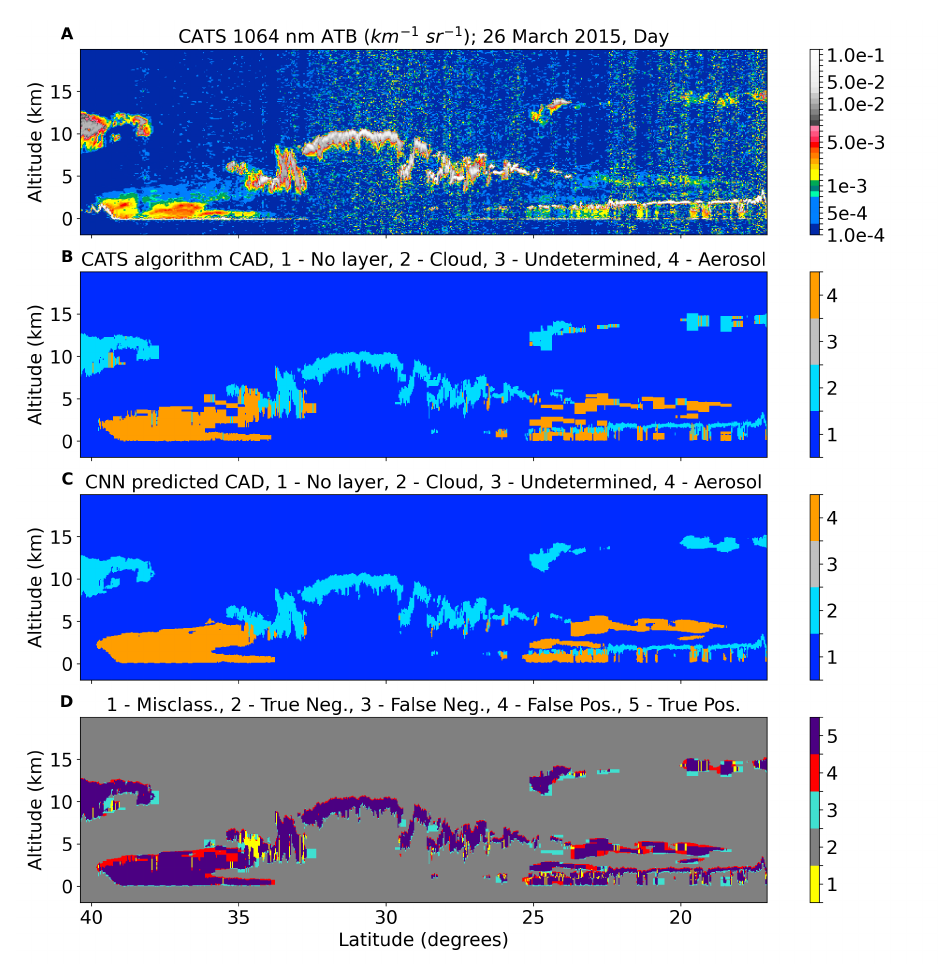
Figure 8D. Furthermore, bins with weak attenuated backscatter within aerosol layers are captured by the CNN technique that are not detected in the operational CAD algorithm, as demonstrated by the “False Positive” assignment (red) in Figure 8D. This results in more homogeneous aerosol layers (Figure 8C, orange) that appear consistent with the attenuated backscatter data, despite the CNN technique only utilizing a 5 km horizontal resolution.